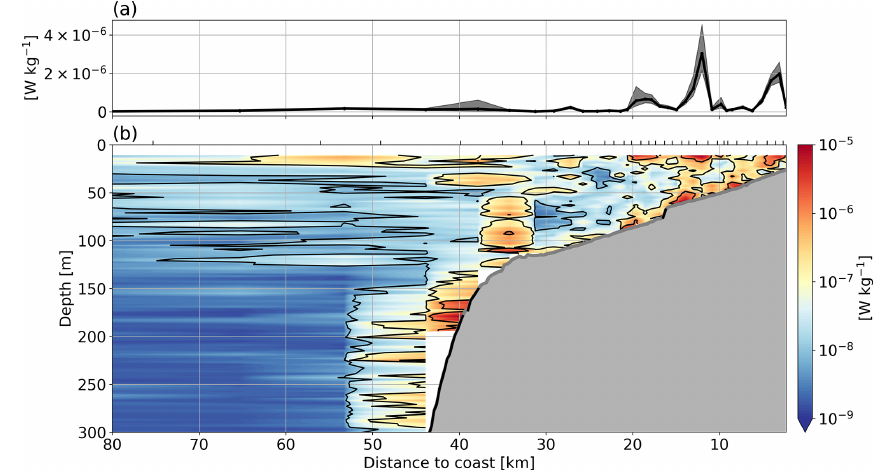
Figure 7. Dissipation of TKE at the 11 ◦ S section (see Fig. 1b) as a function of distance to coast [km]. Microstructure data are binned together in groups of 20 profiles. (a) Mean dissipation of TKE averaged between 2 and 15m below the ML. Grey shading shows 95% confidence interval calculated via bootstrapping. (b) Section of mean dissipation of TKE against depth and distance to the coast. Topography coloured in black marks supercritical slopes for the M2 tide calculated with the time-averaged 11 ◦ S stratification from Kopte et al. (2017). Black ticks at the top of (b) mark the borders of the 20-profile groups.